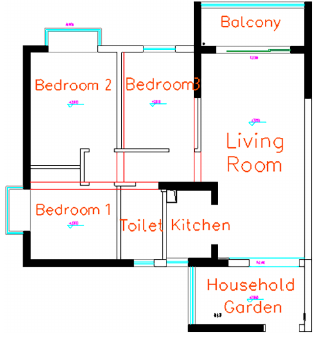
Figure 4. Design drawing of a residential household in Shenzhen (source: A Shenzhen decoration